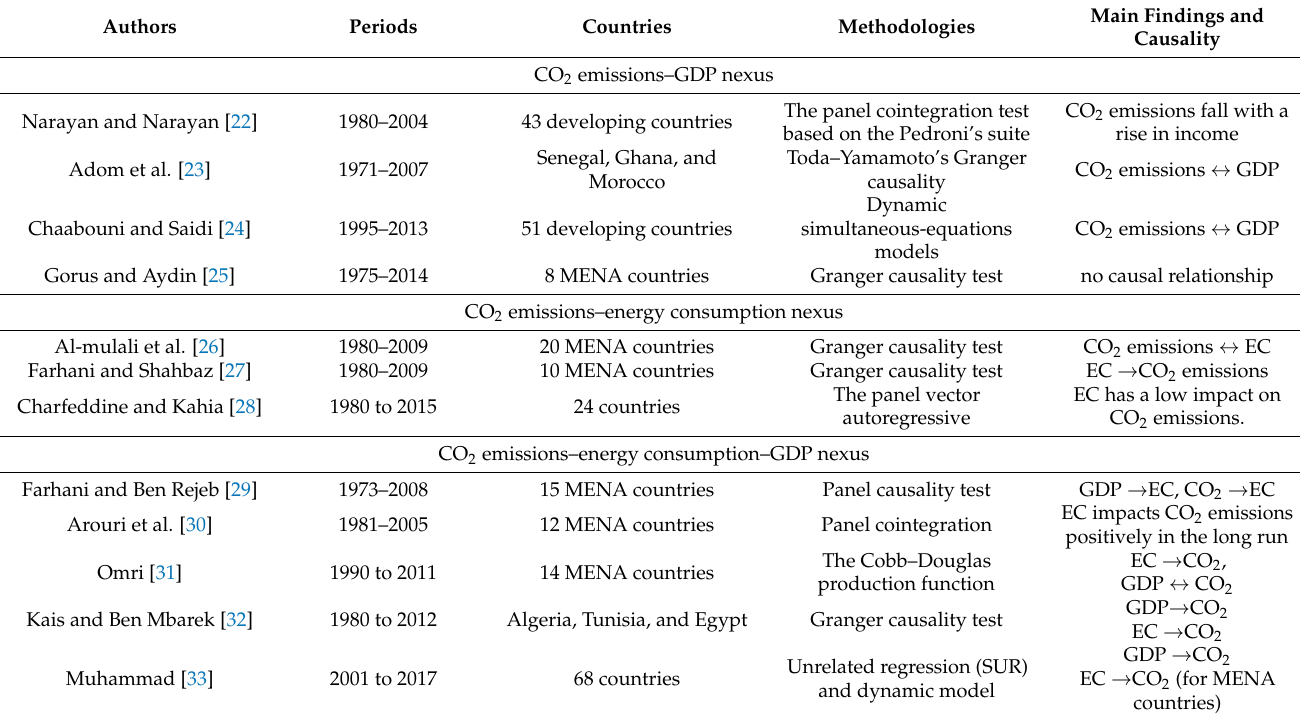
Table 1. Summary of main studies on CO 2 emissions–energy consumption–GDP nexus for MENA